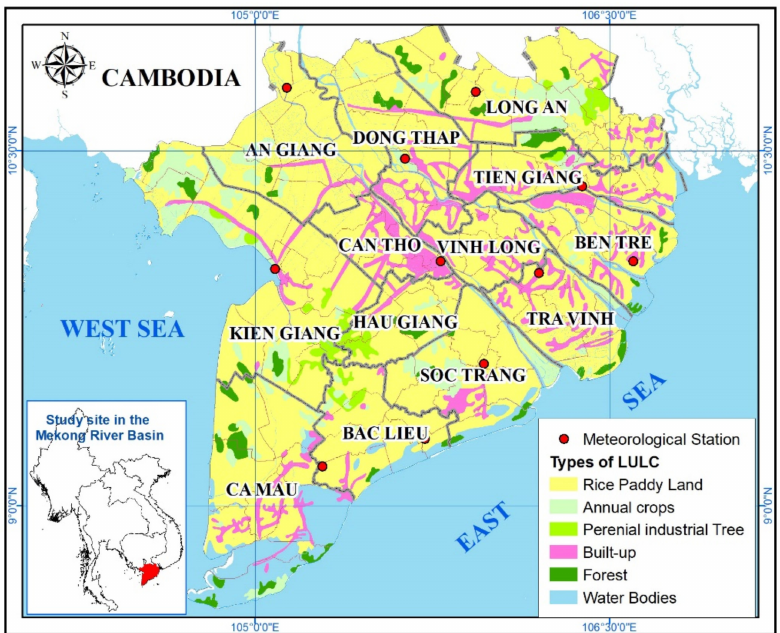
Figure 1. Location of the study area and list of meteorological stations in the Mekong River Delta